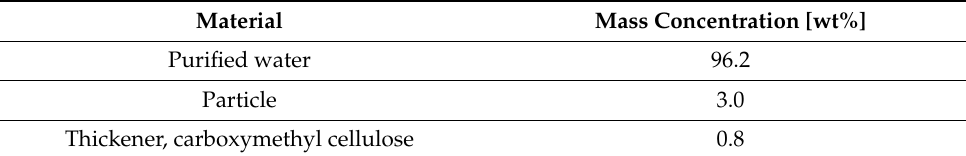
Table 2. Components of the sample Nos. 1–10.